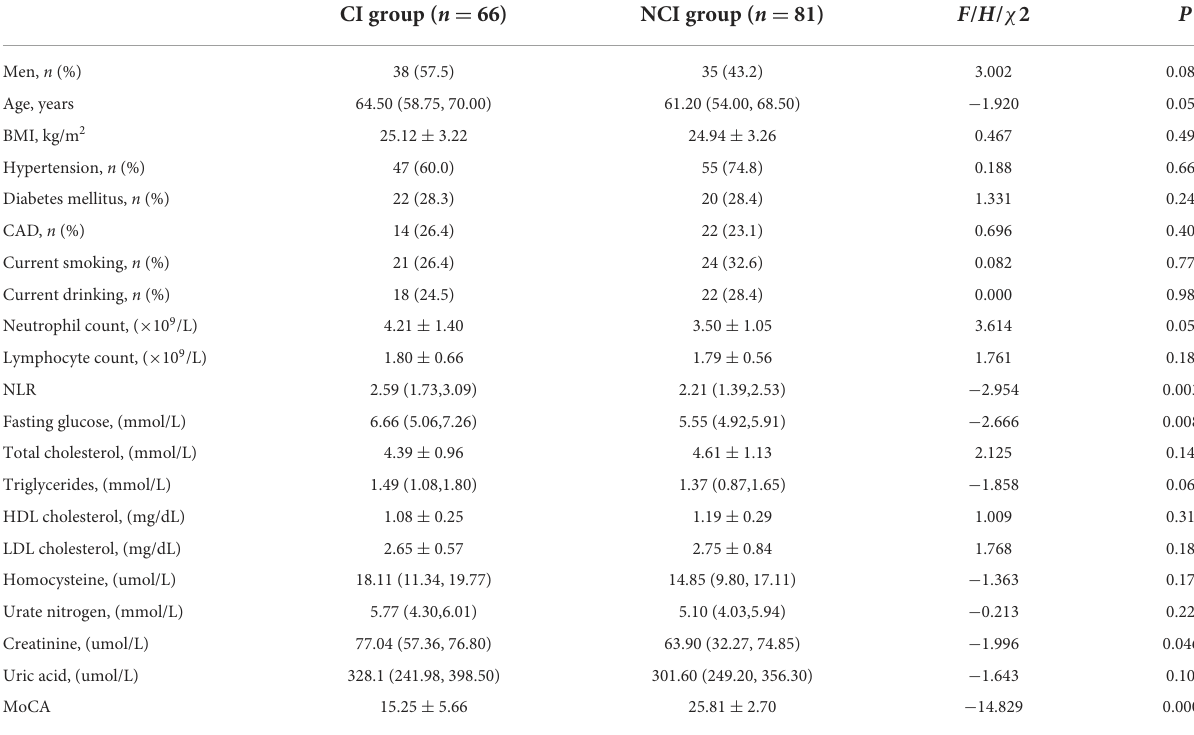
TABLE 1 Clinical characteristics of participants according to cognitive assessment.